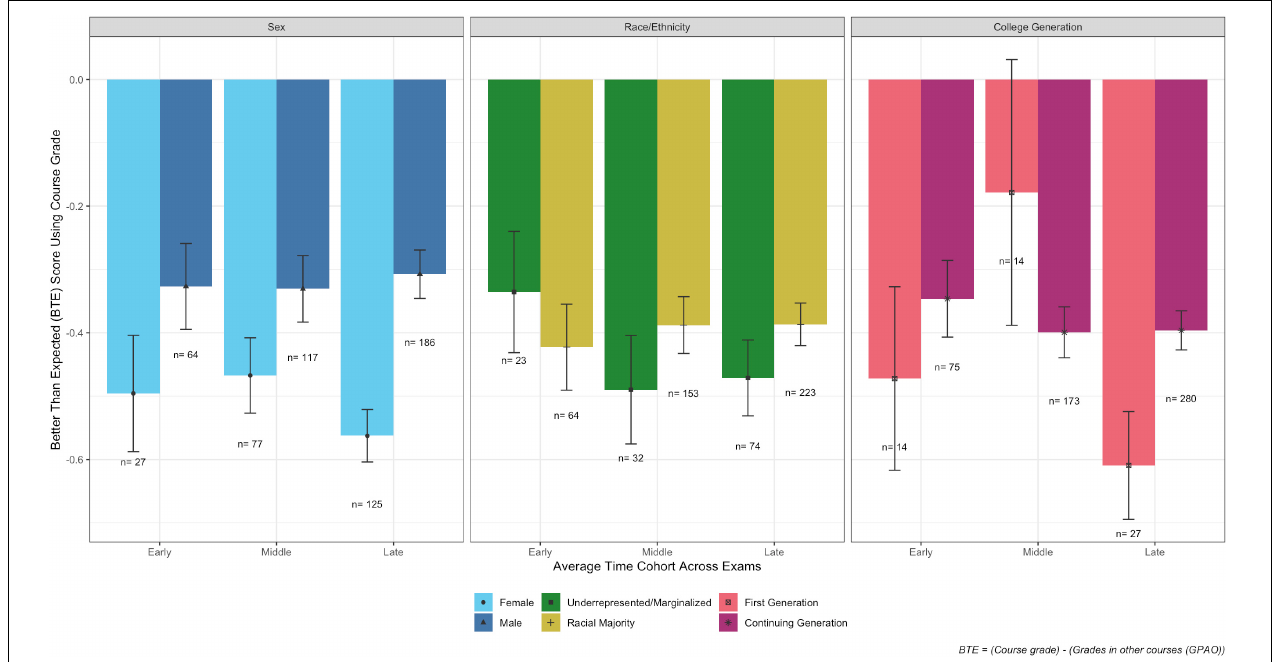
FIGURE 7 | Class BTE scores by average time cohort and demographic